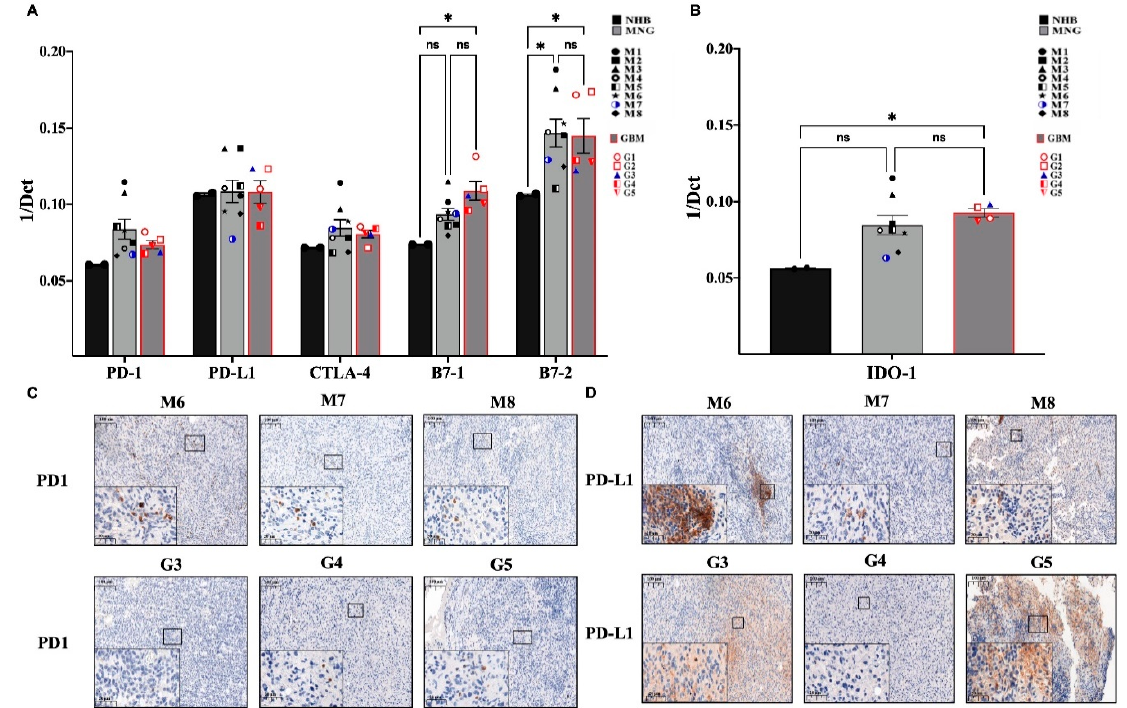
Figure 4. Immune checkpoint molecules that mediate immune therapy response in MNG and GBM. ( A ) mRNA expression levels of PD-1, PD-L1, CTLA-4, B7-1, and B7-2 in MNG and GBM patient samples. ( B ) mRNA expression levels of Indoleamine 2,3-dioxygenase-1 (IDO-1) were tested in MNG and GBM. Data are presented as 1/dCt individually and as average ± SEM. Significant changes are marked as * ( p < 0.05). ( C , D ) Both MNG and GBM samples were stained for PD-1 and PD-L1, magnification ×20 and ×40, size bar 100 and 20 µm respectively.